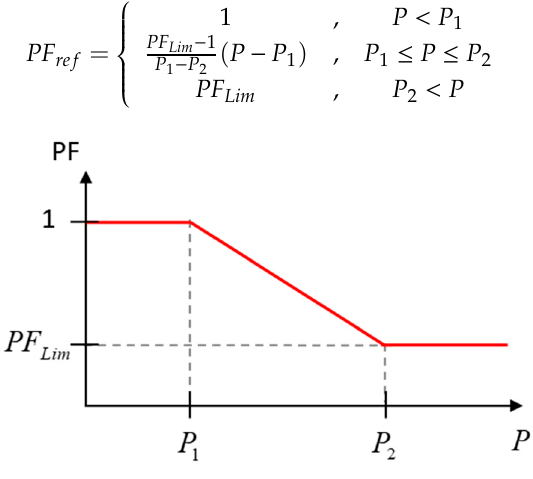
Figure 2. Characteristic curve of Q(V) control method.